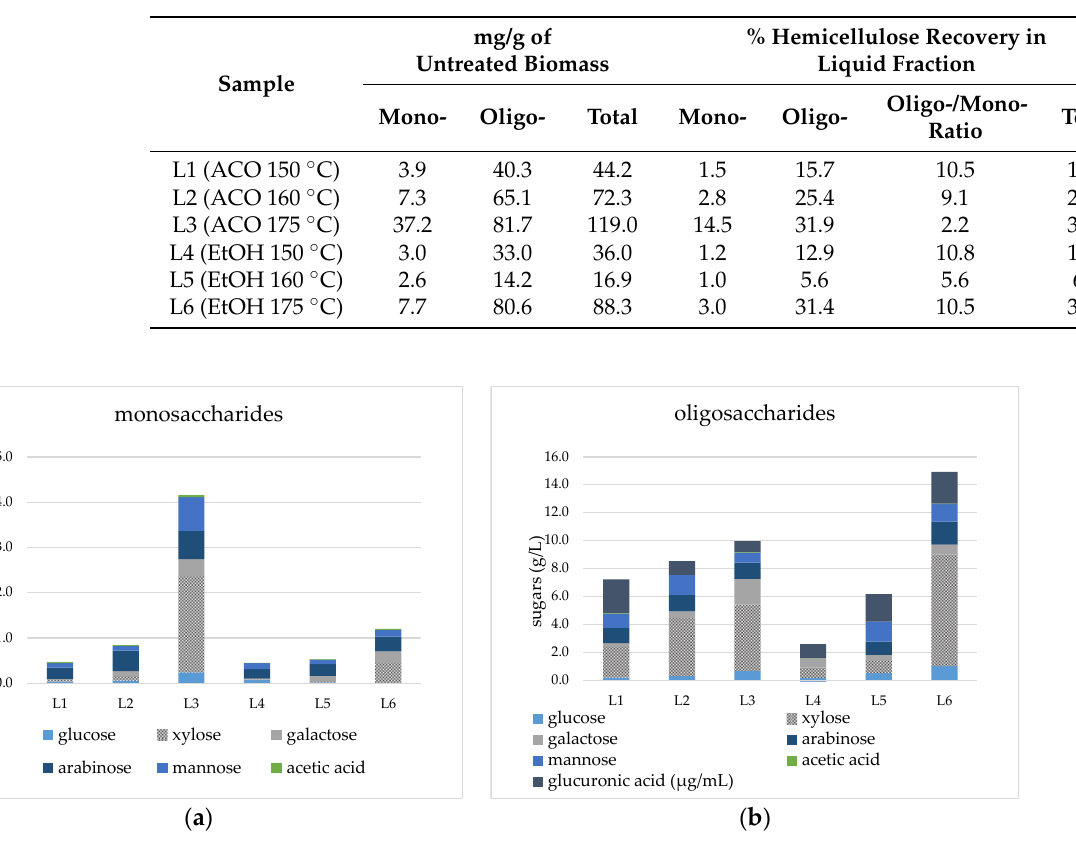
Figure 1. Compositional analysis and hemicellulose sugar profile of liquid fractions. The concentration of sugars in the form of ( a ) monosaccharides and ( b ) oligosaccharides is presented. Standard error is ≤ 2.5% in all measurements.